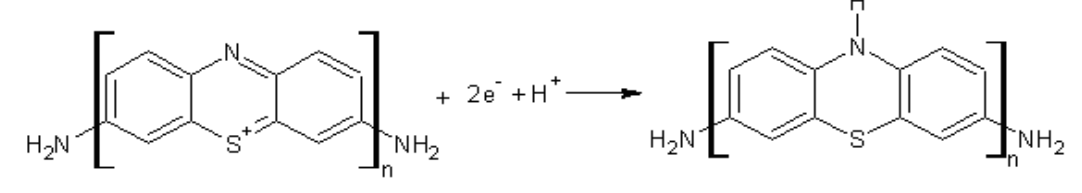
-BSA- 1 -BSA-conjugate and 1